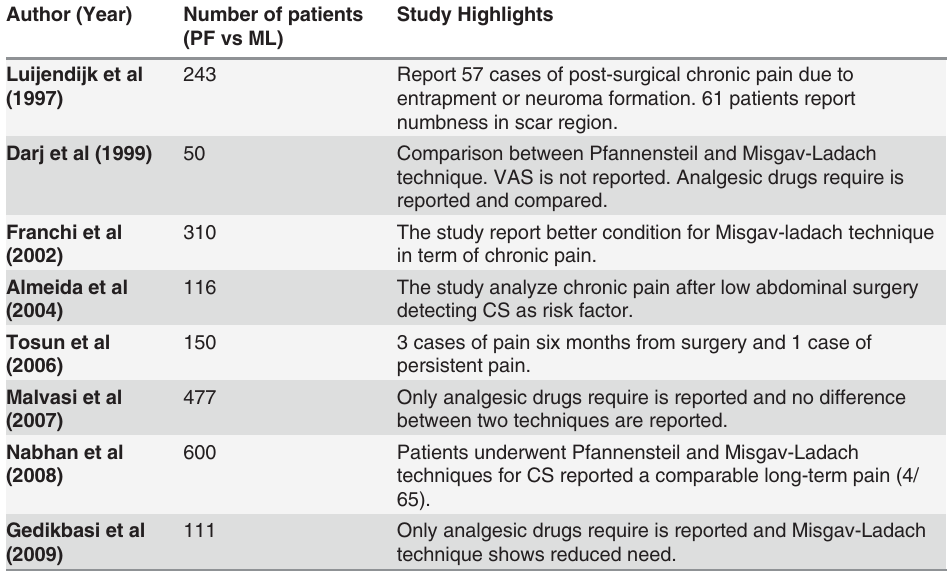
Table 3. Data about incomplete manuscripts (lacking data about VAS values, reporting acute and/or chronic pain outcome indirectly evaluated by analgesia request, duration of subjective pain, women satisfaction) also considered in systematic